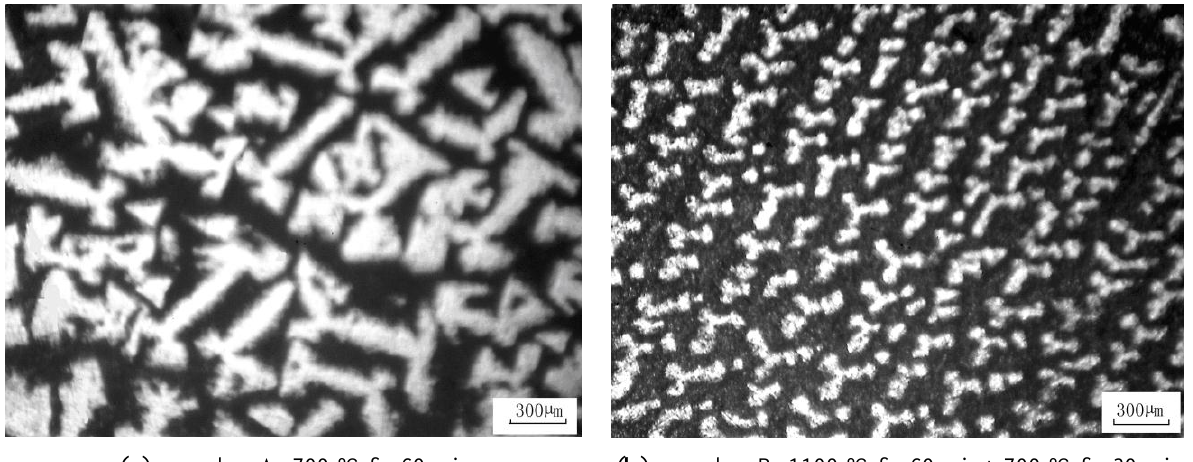
Figure 19. Solidified structures of the Bi-Sb10 (wt %) alloy from different liquid states.